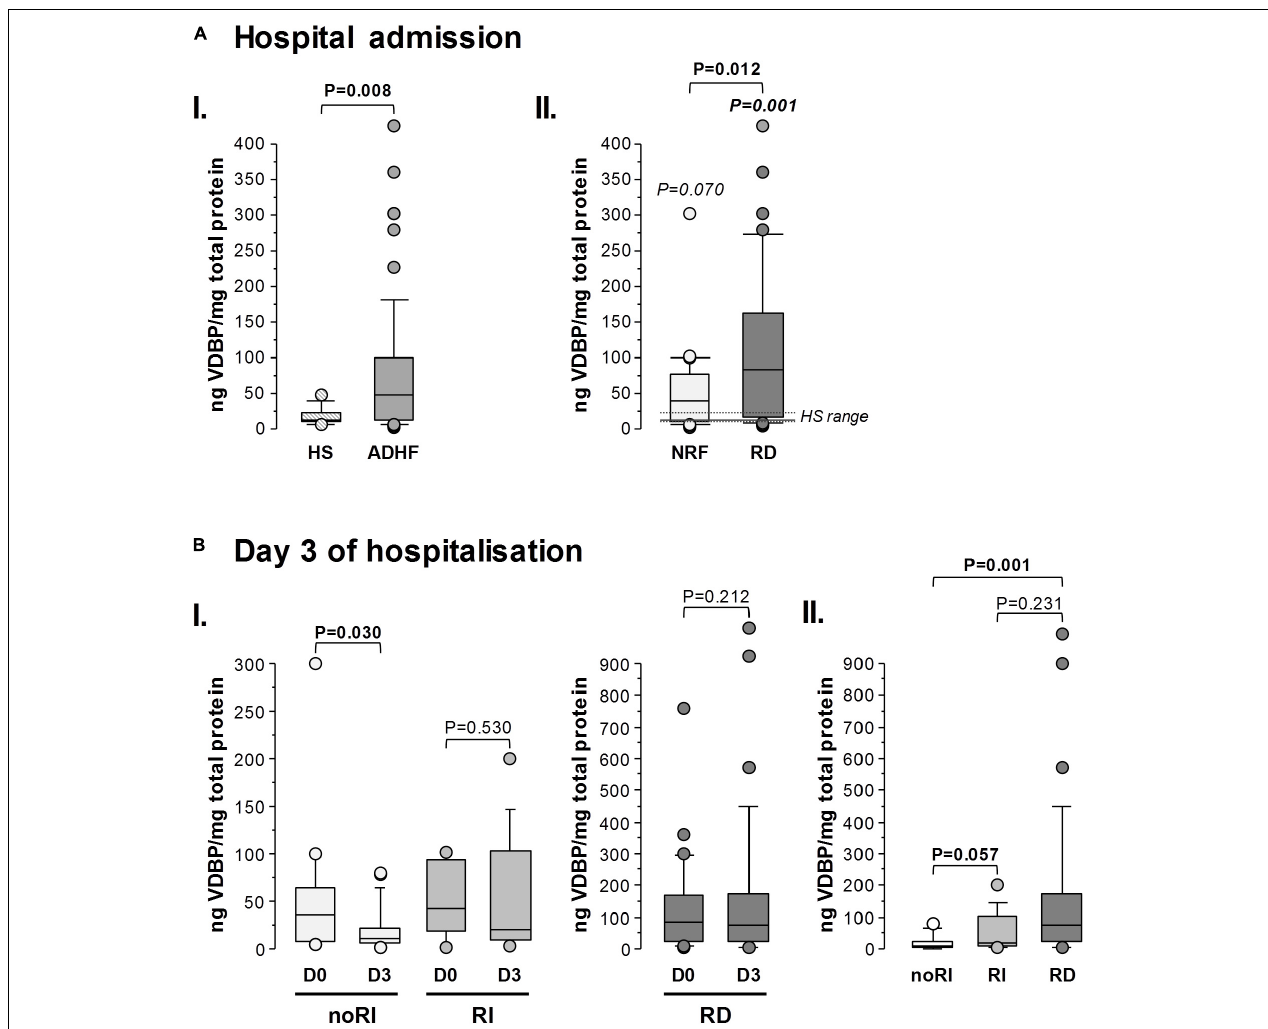
FIGURE 3 | Urinary VDBP in patients with ADHF during hospitalisation: validation studies. Box plot diagrams [median (IQR)] refer to levels of urinary VDBP quantified by ELISA. VDBP in urine was normalised by the total protein content in each sample and expressed as ng VDBP/mg total protein. The Mann-Whitney test was performed for comparison between groups at: (A) hospital admission, (I) patients with ADHF ( N = 64) vs. healthy subjects (HS, N = 13), (II) patients with ADHF with glomerular filtration rate (GFR) below ( N = 34) and above 60 ml/min/1.73 m 2 at hospital admission ( N = 30); (B) 3 days of hospitalisation, (I) comparison between day 0 (D0) and day 3 (D3) for patients with ADHF maintaining normal renal function (noRI: N = 21) and presenting with renal function deterioration (RI: N = 13) after 3 days hospitalisation, and in patients with present renal dysfunction at hospitalisation (RD, N = 30); and (II) comparison between ADHF subgroups (Mann-Whitney test was performed after the Kruskal-Wallis test for multiple group comparison showed P -value <